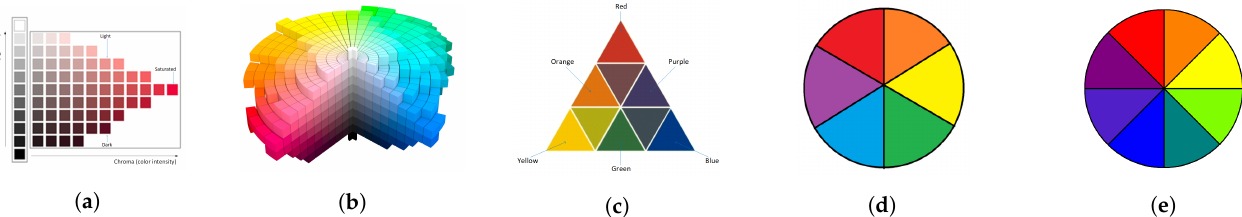
Figure 1. ( a ) Lighted (L), saturated (S), and Dark (D) color tones for red and achromatic colors. ( b ) 3D representation of Munsell color system renotations with a slice cut away for visualization [31]; ( c ) Goethe’s Colour Triangle with primary and secondary colors; ( d ) color wheel for simplified watch pattern; ( e ) color wheel for extended watch